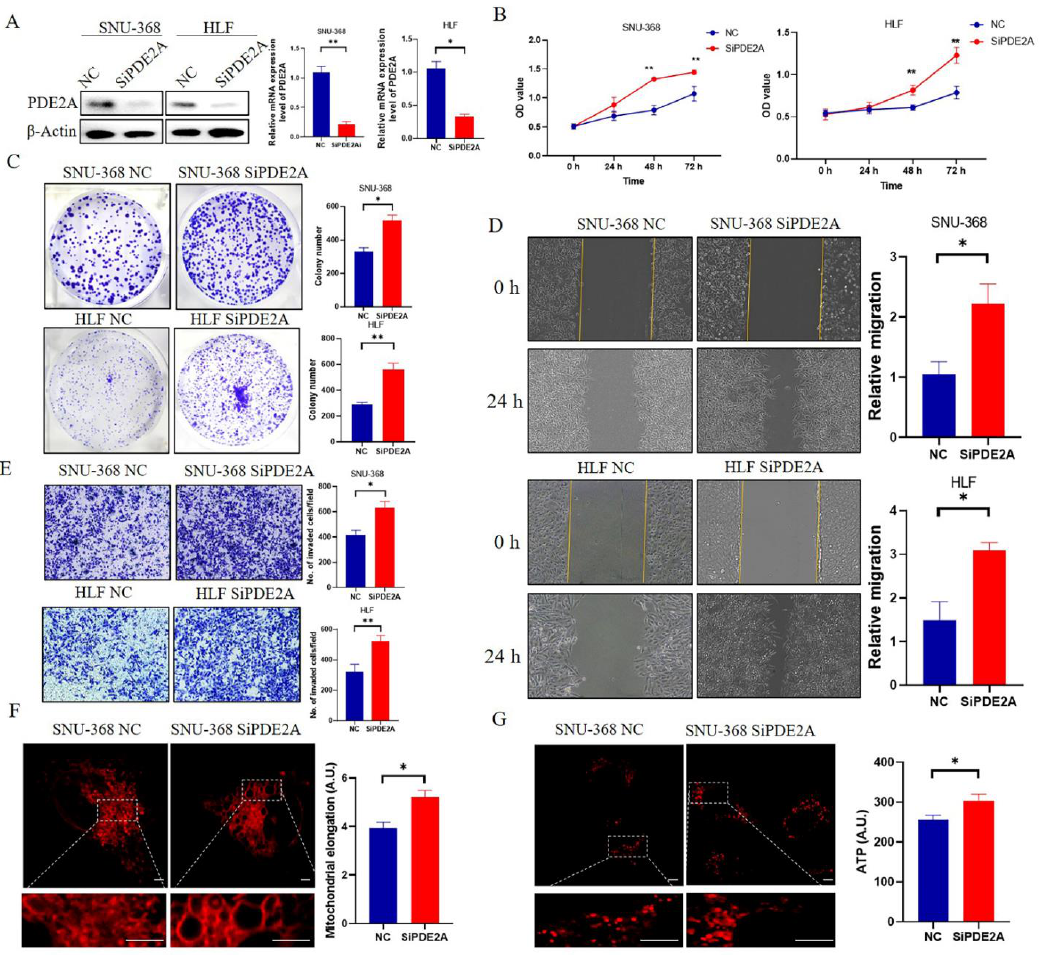
Figure 7. Knockdown of PDE2A promotes the proliferation, colony formation, migration, and invasion of HCC cell lines ( A ) Western blot and RT-qPCR analysis for the protein and mRNA level in HCC cell lines SNU-368 and HLF under PDE2A-siRNA treatment and negative control (NC). ( B ) Cell proliferation assay evaluated by MTS in HCC cell lines SNU − 368 and HLF under PDE2A- siRNA treatment and NC as control. ( C ) Colony formation assay in HCC cell lines SNU − 368 and HLF under PDE2A − siRNA treatment and NC as control. ( D ) Cell migration ability evaluated by scratch wound healing in HCC cell lines SNU − 368 and HLF under PDE2A − siRNA treatment and